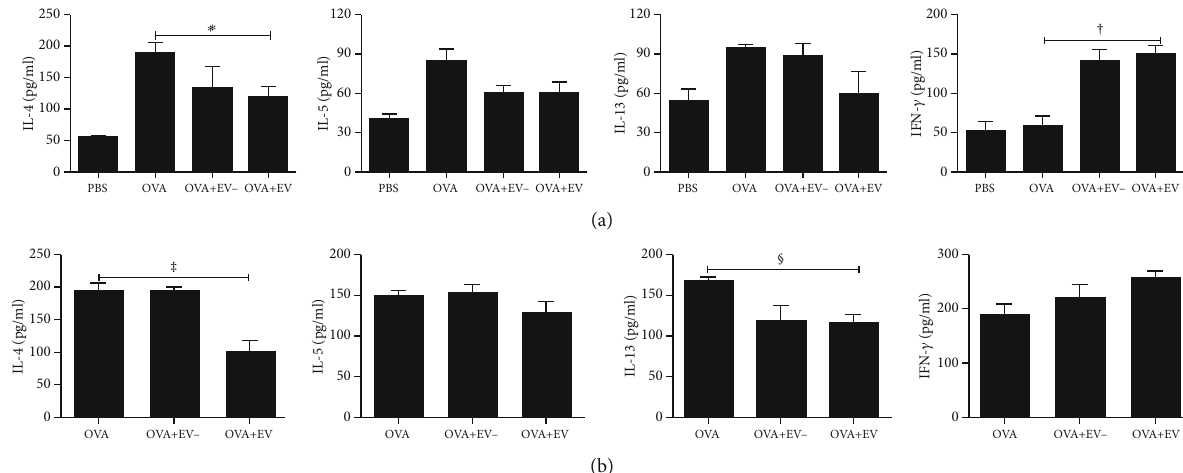
Figure 6: E ff ects of adipose stem cell- (ASC-) derived extracellular vesicles (EVs) on cytokine levels by ELISA in the bronchoalveolar lavage fl uid (BALF) (a) and lung draining lymph nodes (LLNs) (b). IL-4, IL-5, and IL-13 levels were signi fi cantly increased in the BALF of the OVA group compared to the PBS group. Treatment with ASC-derived EVs remarkably reduced the levels of IL-4 but increased the levels of IFN- γ in the BALF. ASC-derived EV treatment notably decreased the levels of IL-4 and IL-13 in the LLNs. Data are expressed as the mean ± SEM of four independent experiments, each performed in triplicate. ∗ p = 0 : 040 , † p = 0 : 006 , ‡ p = 0 : 011 , and § p = 0 : 012